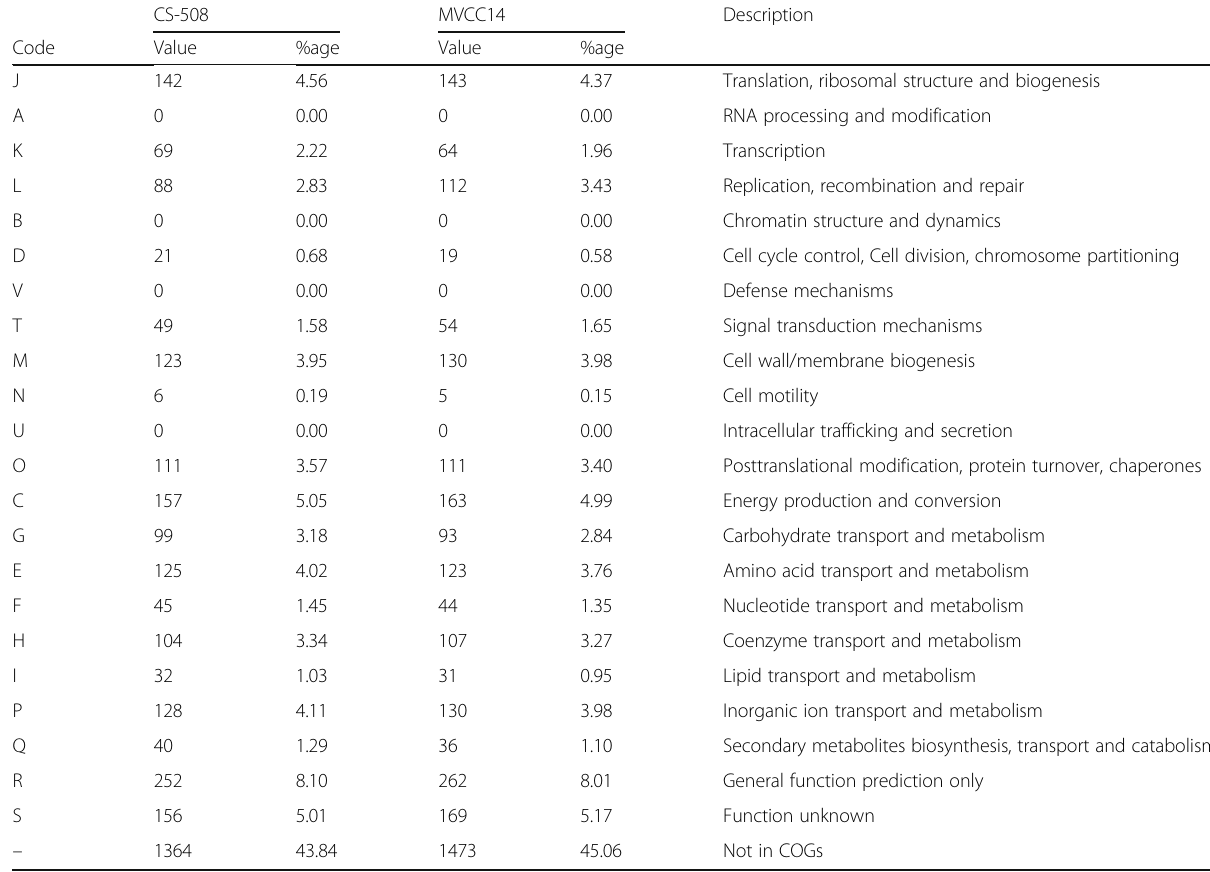
Table 5 Number of genes associated with general COG functional